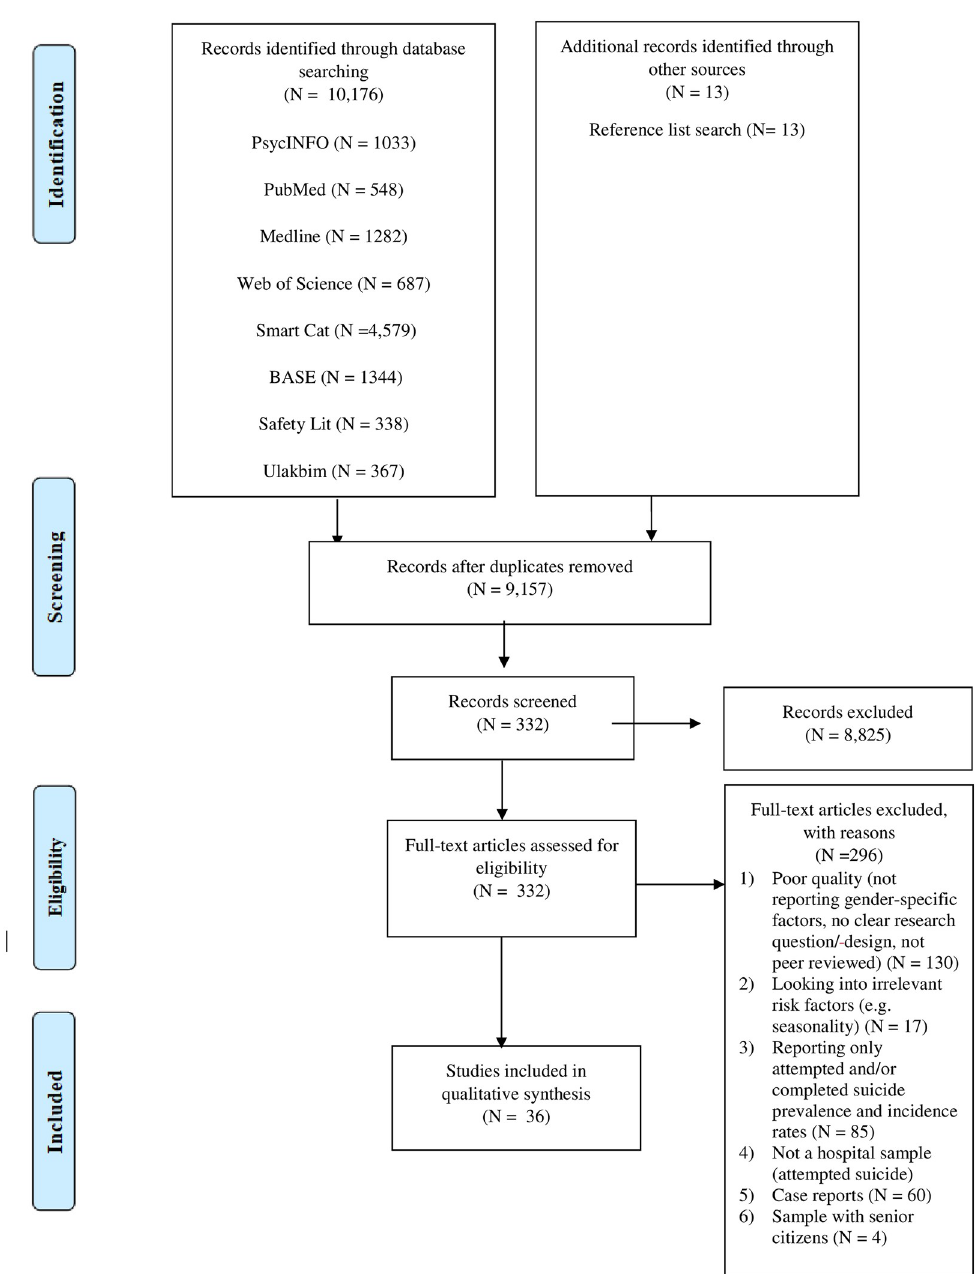
Fig 1. Prisma flowchart: Flow of studies on suicide and attempted of Turkish women in Turkey and Europe. Eligible studies were retrieved by the systematic literature search and article selection process, consisting of the following steps: identification of records, screening for inclusion, assessing of studies eligibility, and inclusion of studies into the integrative research review.